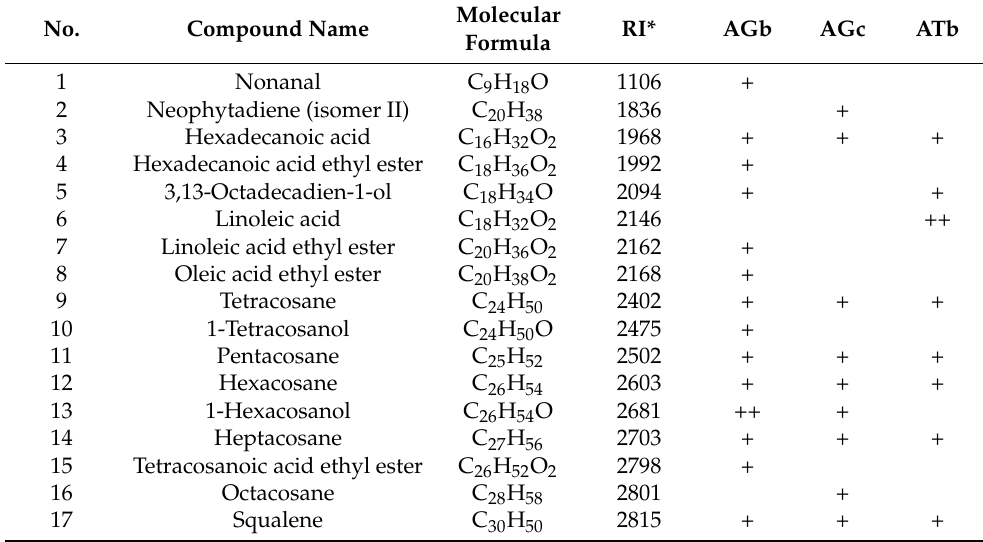
Table 2. The list of compounds identified in diethyl ether extracts of Kazakhstani onions— Allium galanthum and Allium turkestanicum after their analysis by GC-MS method.